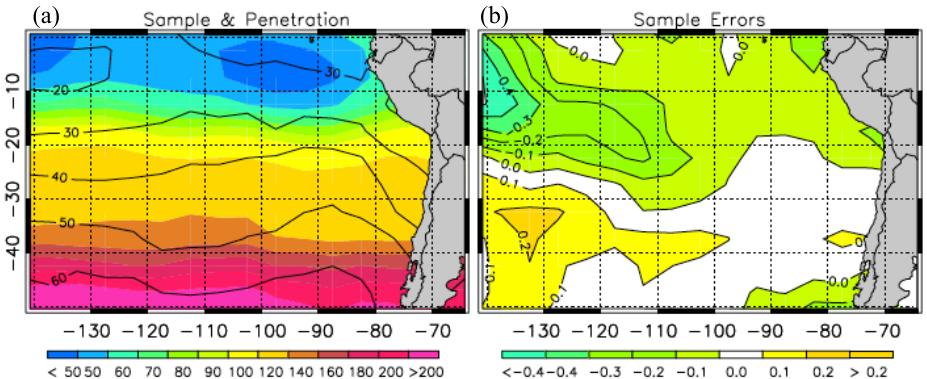
Fig. 8. (a) Number of COSMIC RO soundings per area of 500km × 500km (shaded); the over-plotted contours denote the percentage of soundings that penetrate below 500-m above the m.s.l.; (b) errors in ABL heights caused by the limited COSMIC RO sampling derived from ECMWF analysis (contours, with 0.1km interval).